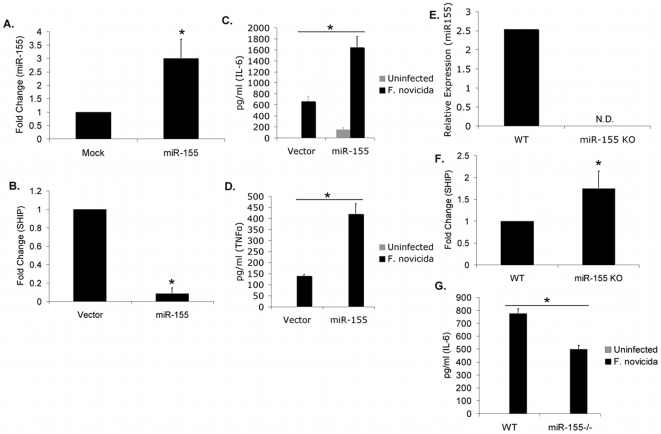
miR-155 promotes pro-inflammatory cytokine production during F.n. infection.(A) PBM were transfected with vector control or miR-155 overexpression construct. 22 hours post-transfection, RNA was extracted and miR-155 over-expression was verified by qRT-PCR. (B) SHIP expression was assayed from the samples in Figure 5A. (C–D) 14 hours post-transfection PBM were infected with F.n. at an MOI of 50 for 8 hours and (C) TNFα and (D) IL-6 measured in supernatants. (E) Wild-type and miR-155−/− macrophages were assayed for miR-155 expression. (F) SHIP expression was assayed by qRT-PCR from the samples in Figure 5E. (G) Wild-type and miR-155−/− macrophages were infected with F.n. at an MOI of 50 for eight hours. IL-6 in the supernatant was measured by ELISA. All experiments were performed in triplicate. Graphs represent the mean and standard deviation of samples from three independent experiments. Data were analyzed by a paired Student t test. An asterisk (*) indicates a p-value<0.05.